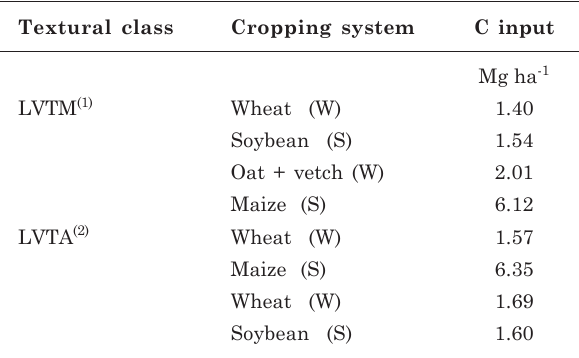
Table 2. Average carbon input derived from the dry matter of winter (W) and summer (S) crops in two soils with different